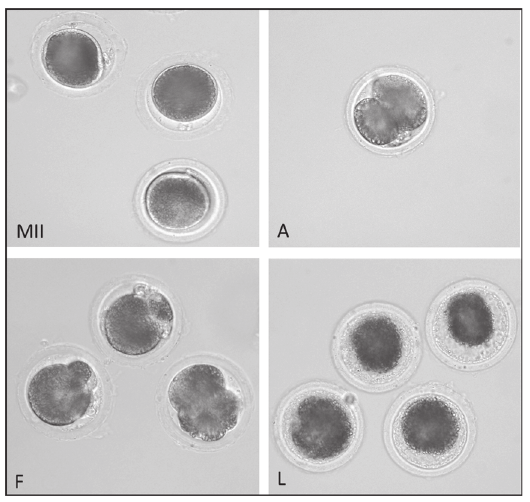
Figure 1. Effect of aging on morphology of porcine oocyte. MII — intact oocyte at metaphase II, A — activated oocyte, F — fragmented oocyte, L — lysed oocyte.